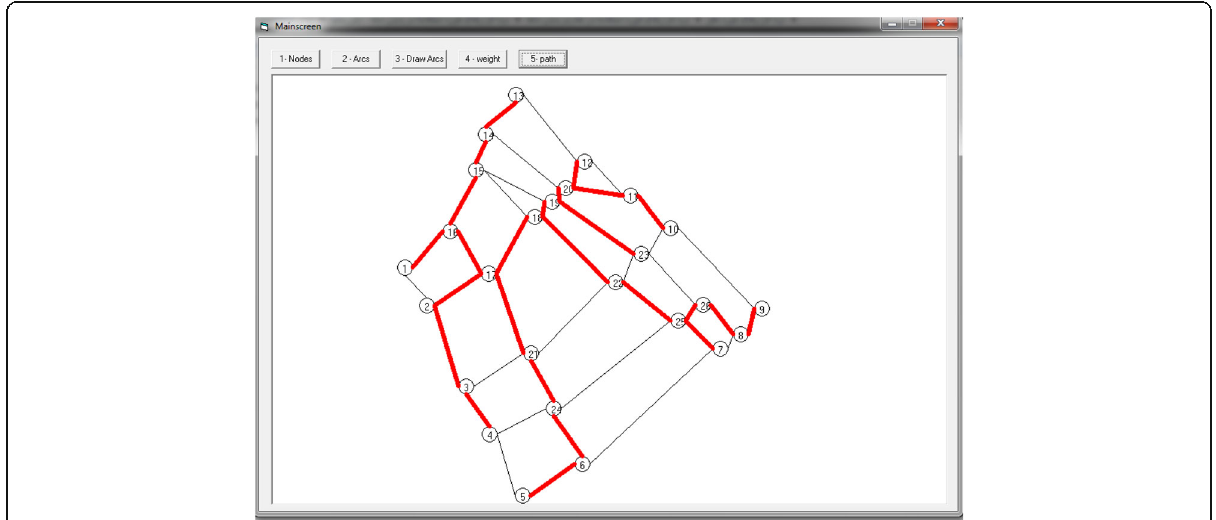
Fig. 18 The Results Derived from Implementing the Model of Roads Length Index on the Sample Data